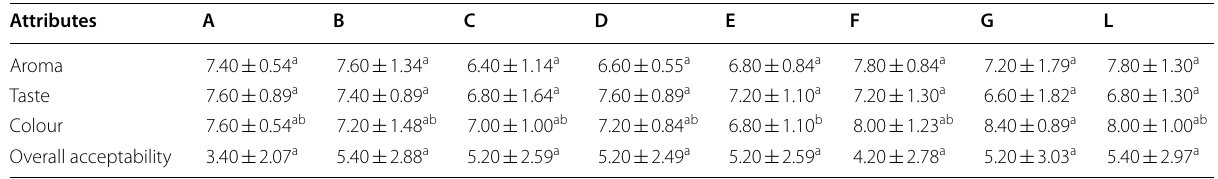
Table 6 Sensory attributes and consumer acceptability of corn silk–lemon and commercial tea infusion